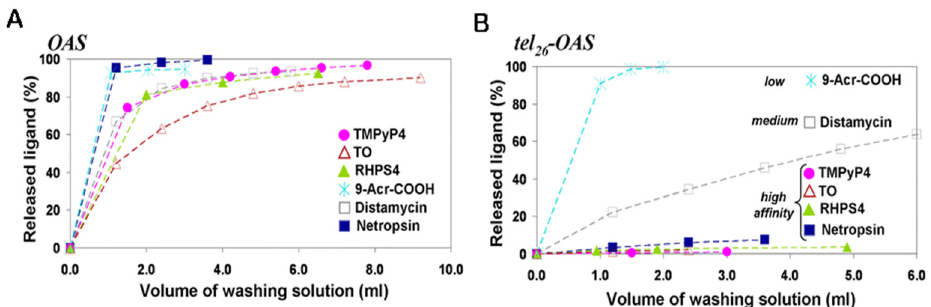
Figure 25. Amount of the released ligands, expressed as percentage of the quantity loaded ( A ) on OAS support and ( B ) on tel26-OAS support, as a function of the washing solution volume (100 mM KCl/15% DMSO). Reprinted from ref. [215].